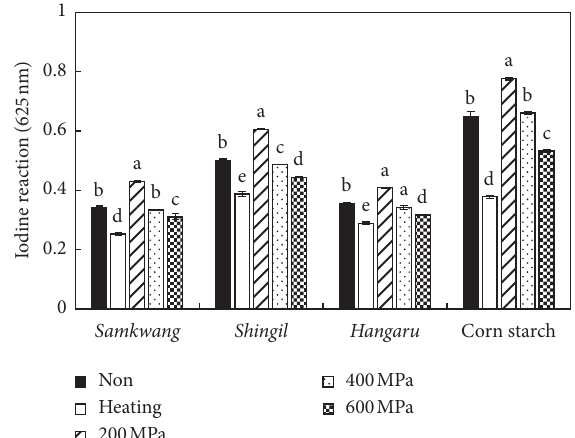
Figure 3: Iodine reaction (625nm) of different rice flours by treatment methods. Values are mean ± SD. n � 3. Different small letters in the same items indicate a significant difference by Duncan’s range test ( p < 0 . 05) according to the treated